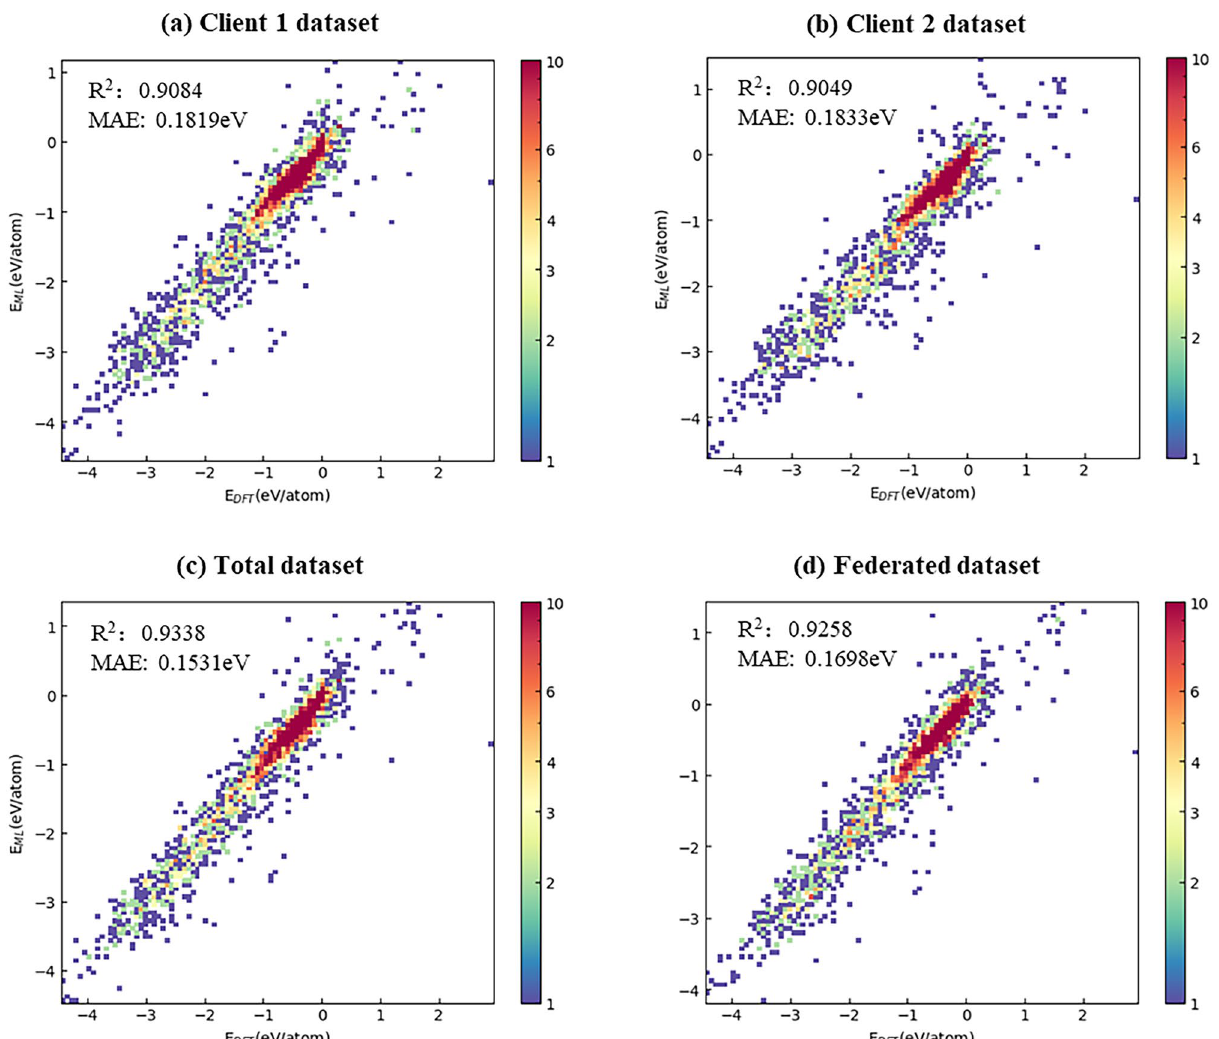
Figure 3. Prediction power of models trained on different datasets and method. ( a ) is for the model trained on the local dataset of client 1, ( b ) is for the model trained on the local dataset of client 2, ( c ) is for the model trained on the total training set, and ( d ) is for the shared model based on federated dataset (client 1 and 2) by using the method we proposed. Among them, different colors indicate aggregation degrees of points, red indicates that the point distribution is clustered, and blue indicates that the point distribution is